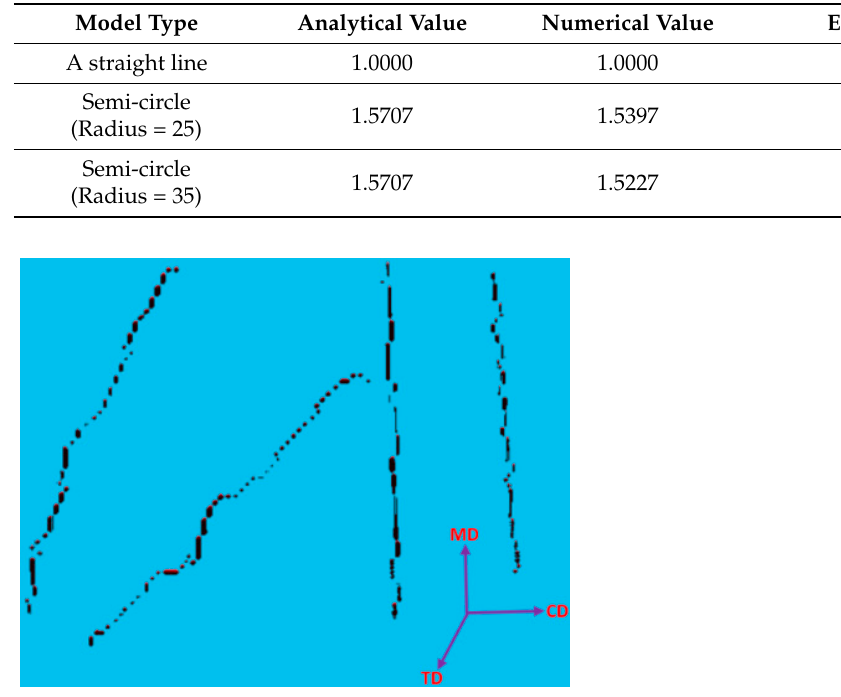
Figure 5. ( a ) Voxelated line and ( b ) voxelated semi-circle. Table 2. Analytical and numerical crimp values of voxelated models.